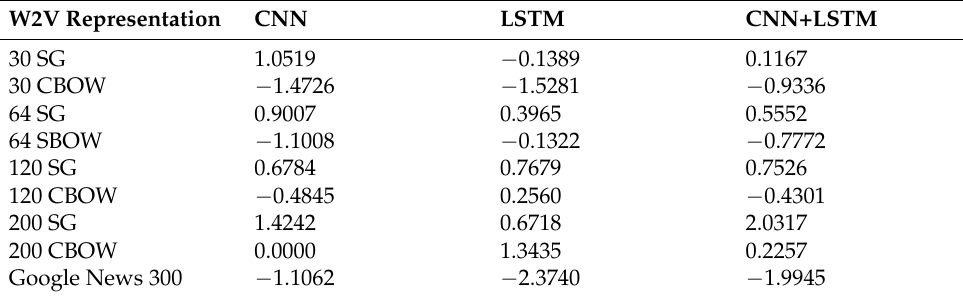
Table 10. List of standardized